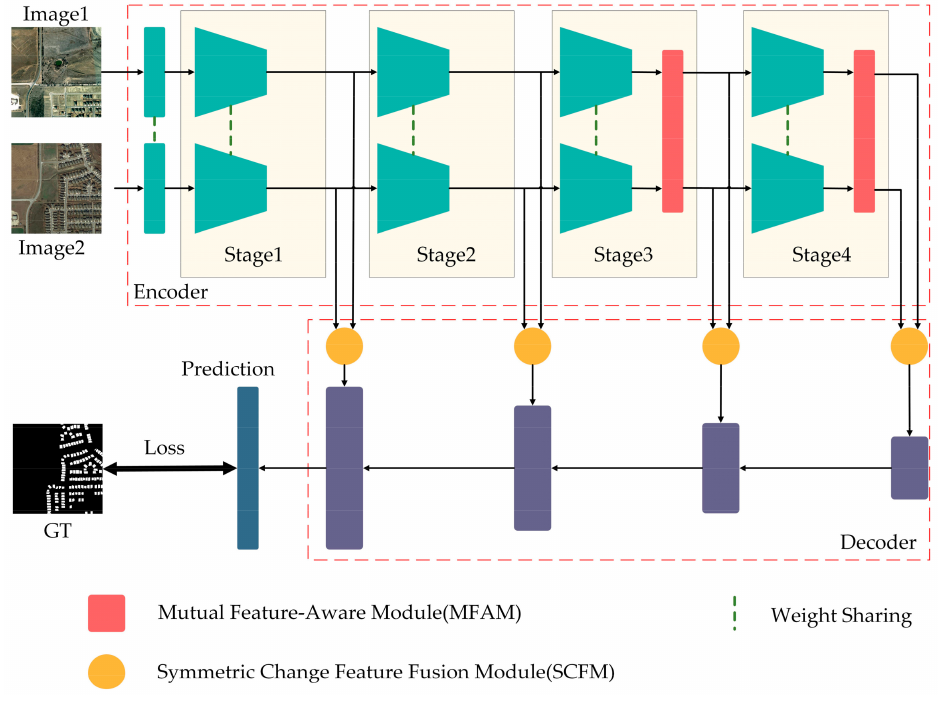
Figure 1. The overall architecture of the proposed